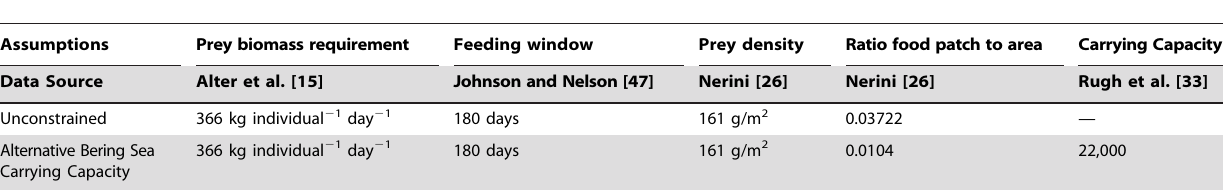
Table 2. Parameters and sources used to estimate carrying capacities for gray whales in the North Pacific Ocean during the last 120